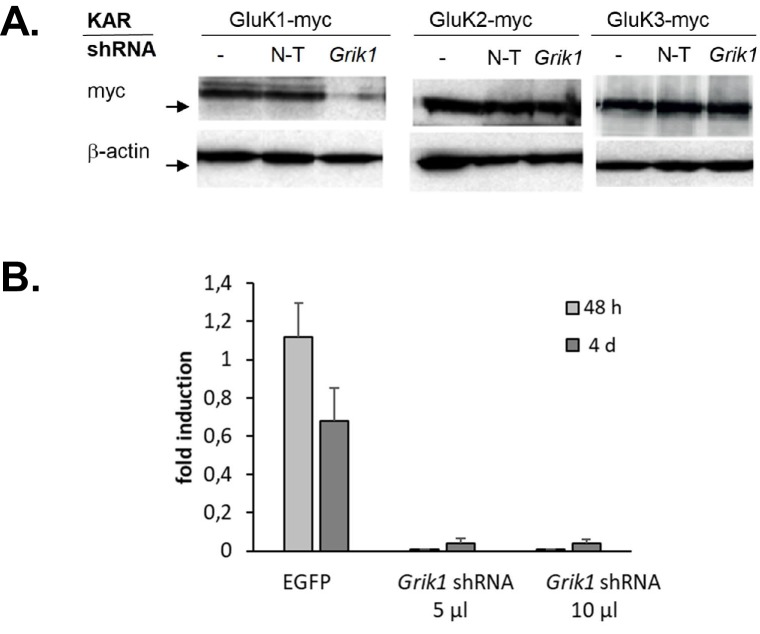
Validation of the Grik1 shRNA.(A) A western blot illustrating that the Grik1 shRNA strongly inhibits expression of GluK1-myc but not GluK2-myc or GluK3-myc in HEK293T cells. (B) RT-qPCR results showing that the lentiviral Grik1 shRNA construct blocks expression of endogenous GluK1 in dorsal root gangion (DRG) neurons within 48 hr from infection.